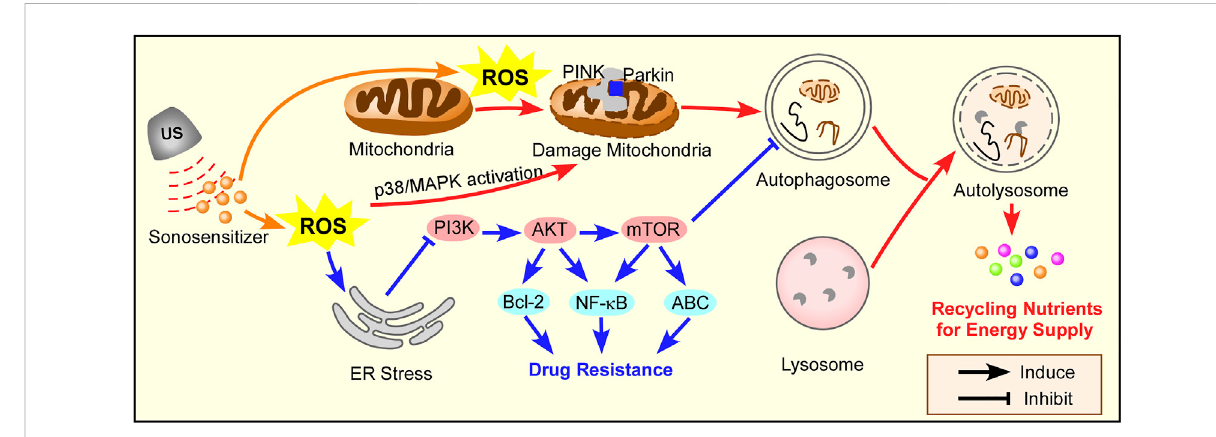
Parkinpathwayincancertherapy.SDTcaninhibitchemotherapysensitivitybyROS-inducedERstress,whichactivatesautophagyinPI3K/AKT/mTOR pathway. Red arrow for cancer therapy, blue arrow for drug resistance in cancer therapy.